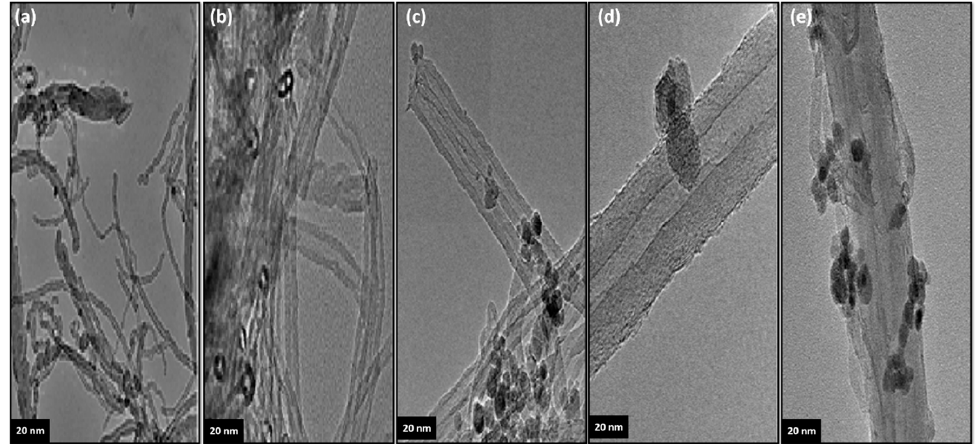
Figure 3. TEM images of the unmodified and the modified carbon nanotubes: ( a ) MWCNT, ( b ) MWCNT–COOH, ( c ) m-MWCNT–HA, ( d ) m-MWCNT–CYS and ( e ) m-MWCNT–HYD. Scale bars: 20 nm.